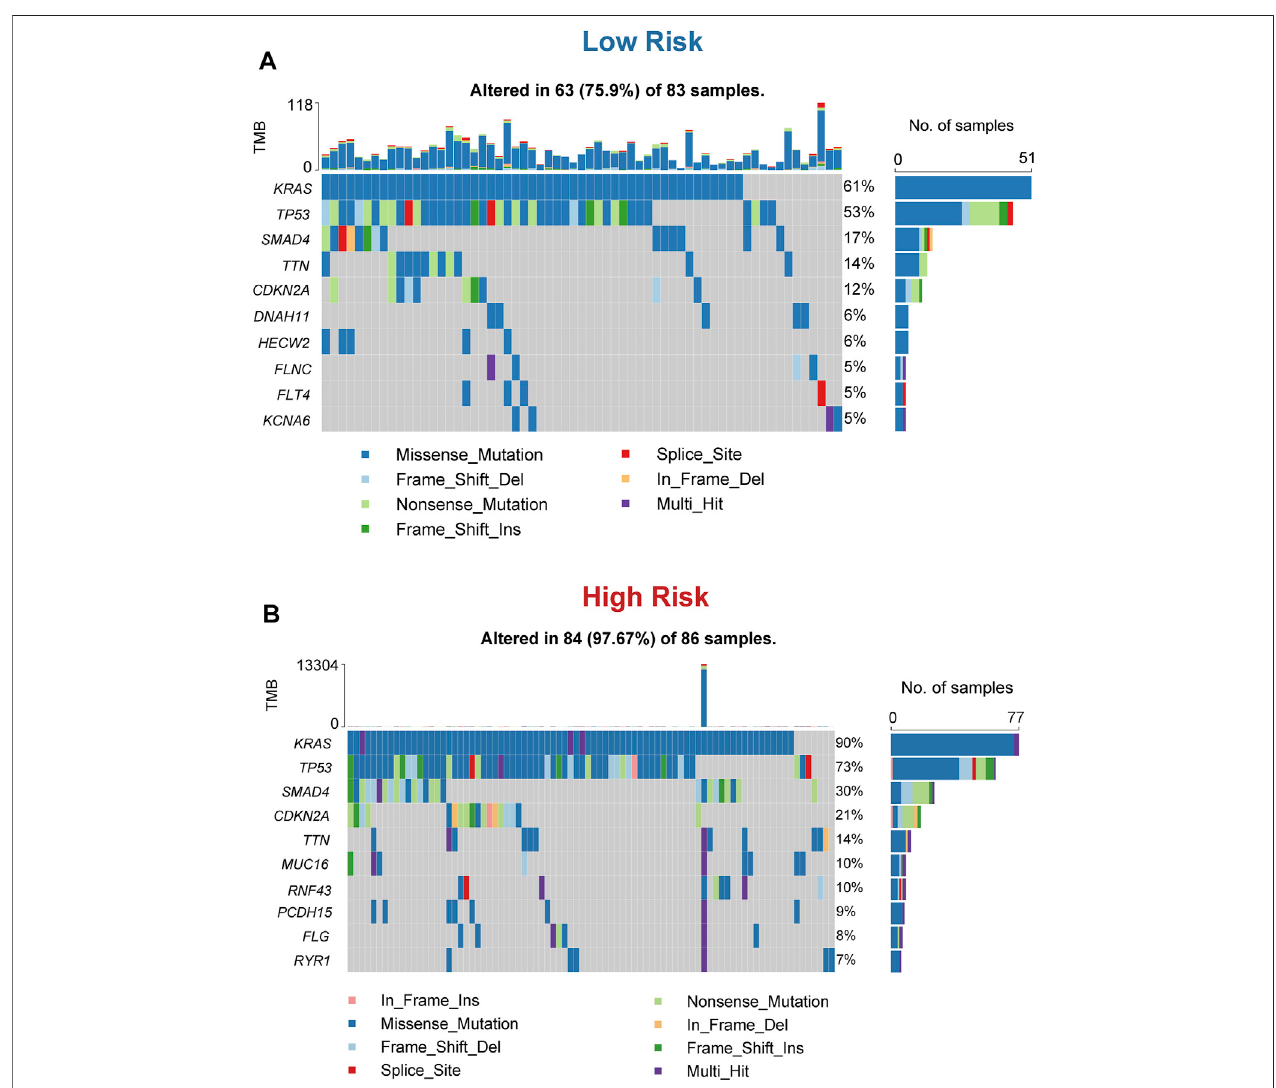
FIGURE9| Mutationallandscapeofthe3-genesignature (A) Waterfallplotofmutationstatusinthelow-riskpatients (B) Waterfallplotofmutationstatusinthehigh- risk patients.